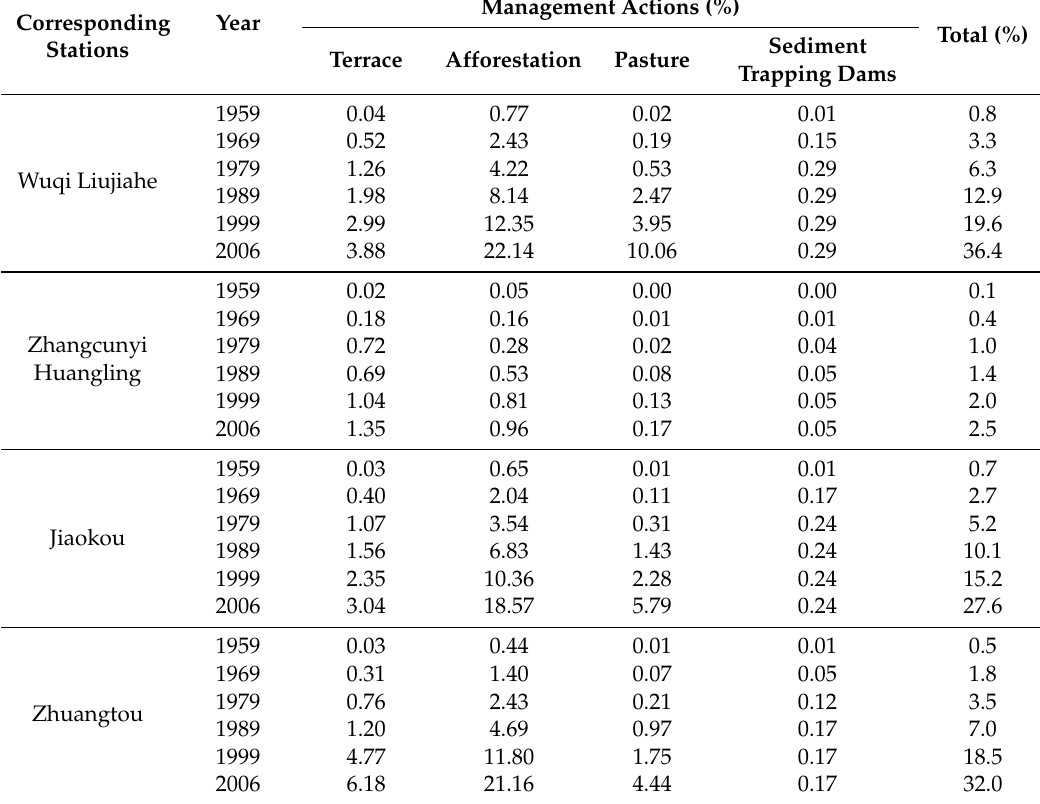
Table 1. Cumulative area treated by management actions in the corresponding sub-catchments from 1959 to 2006 [14,18,19]. Corresponding